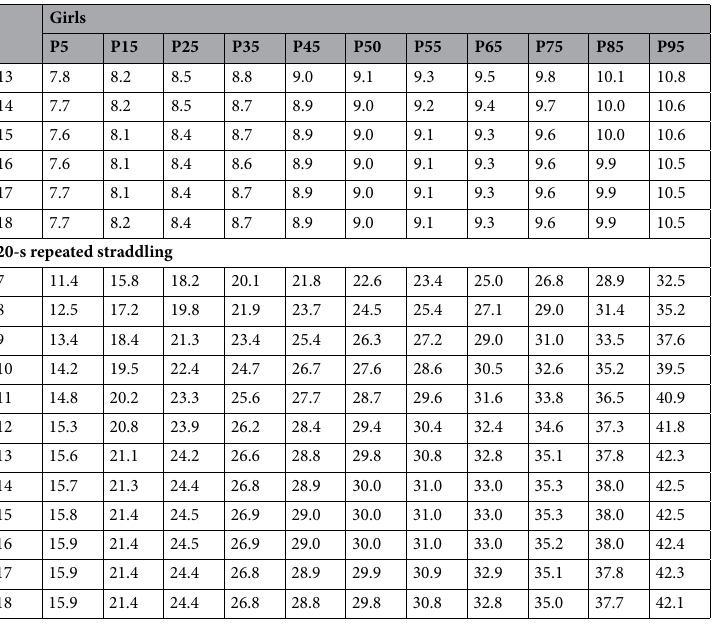
Table 2. Reference standards of the seven physical fitness tests by age and sex for Chinese children and